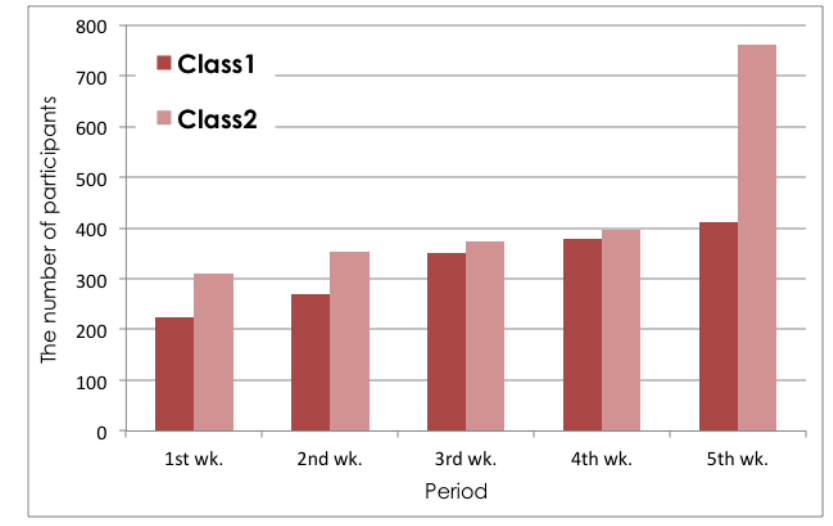
Figure 6 Number of participants joining the